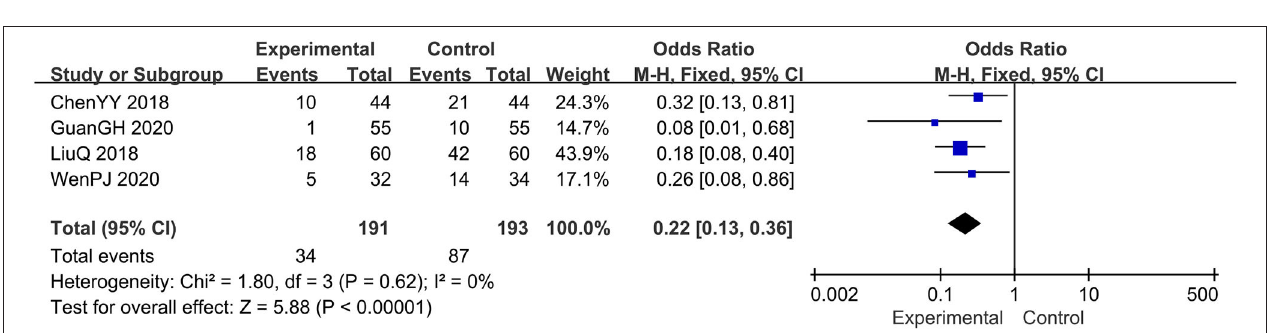
FIGURE 9 | The meta-analysis for comparison of combination therapy vs. prednisone for the adverse events.